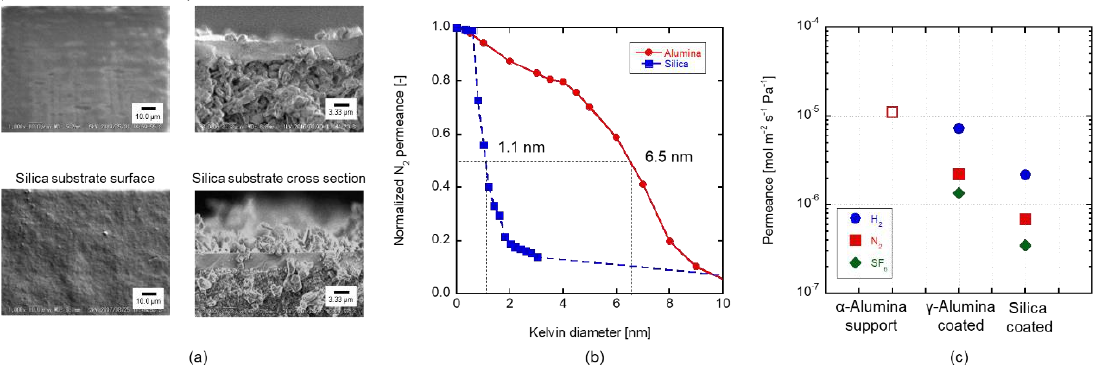
Figure 7. Characterization of the γ -alumina and silica substrate ( a ) the surface and cross-sectional view of the intermediate layer coated substrate, ( b ) the results of the nanopermporometer, and ( c ) the gas permeance.